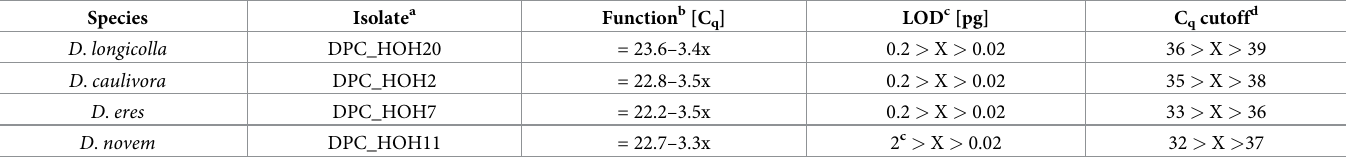
Table 3. Functions and additional information derived from standard